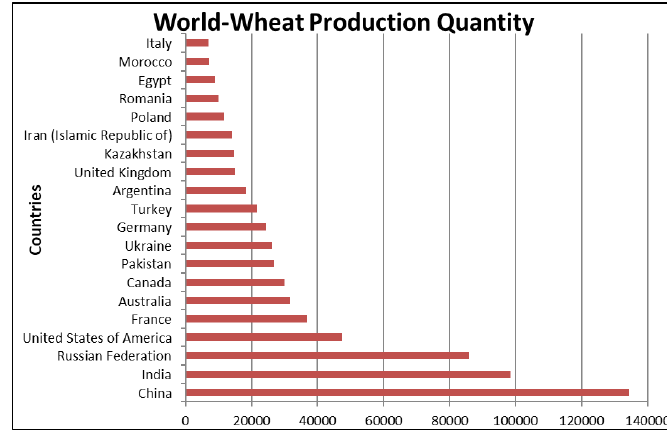
Figure 2: The production amount of top 20 wheat producing countries in